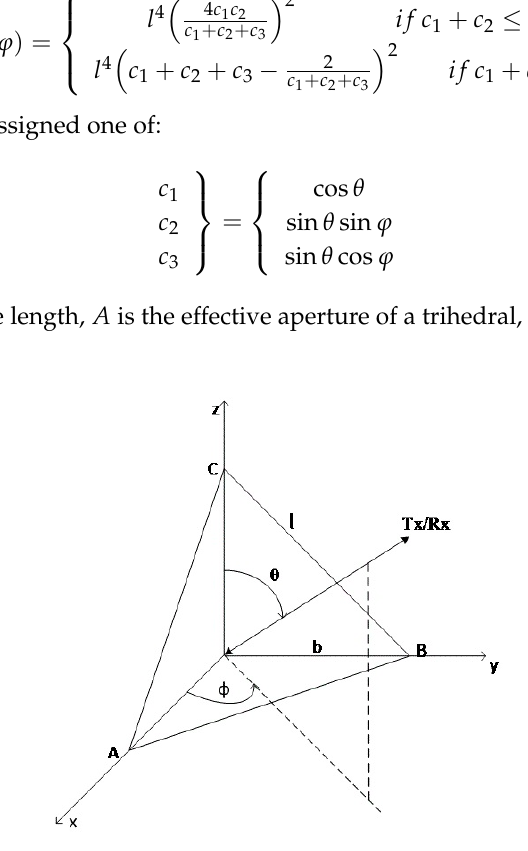
Figure 4. The monostatic RCS observation geometry of the trihedral corner reflector (TCR).